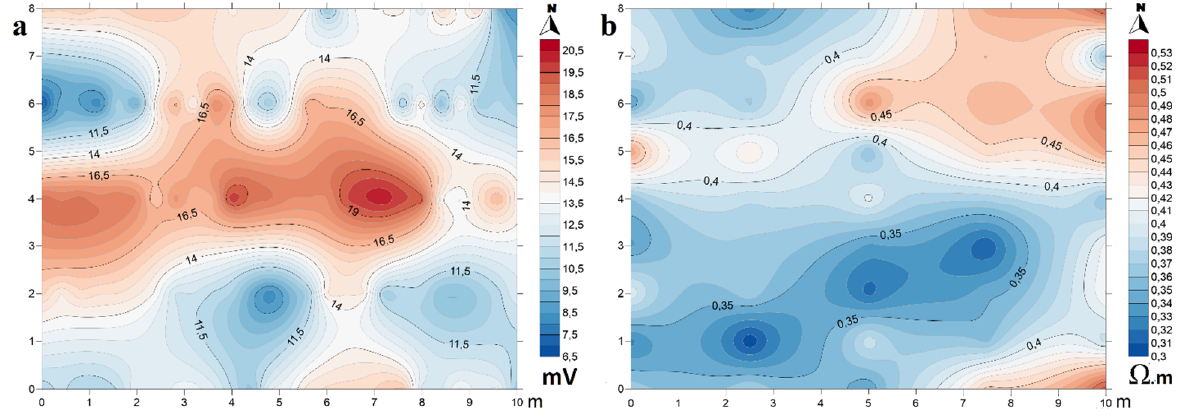
Figure 7. ( a ) Spontaneous potential map and ( b ) calculated apparent resistivity gradient map of the same plot surveyed at Farm A.